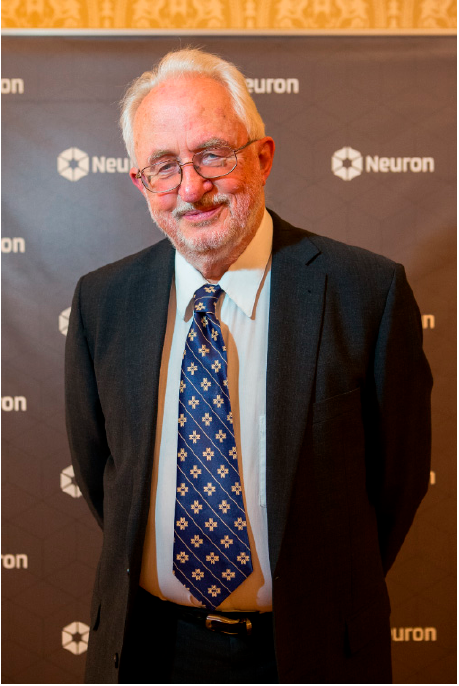
Figure 1. Josef Michl, credit from Neuron Foundation.